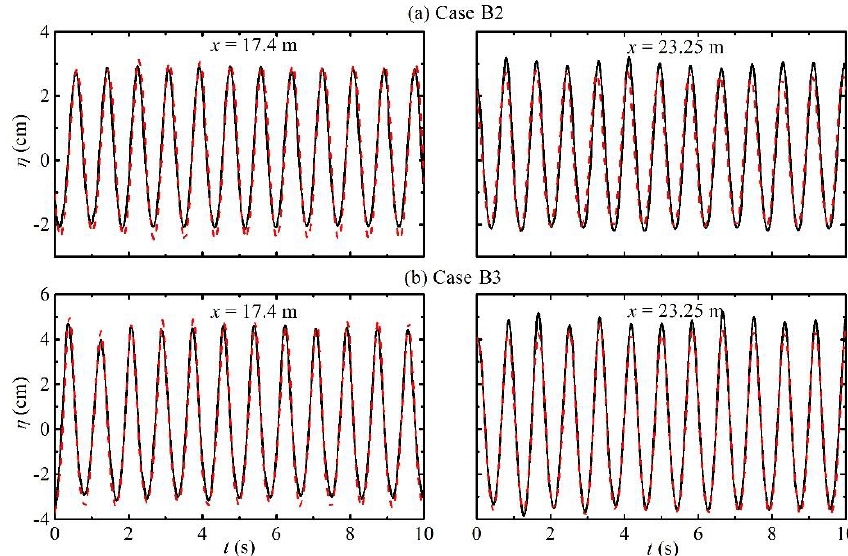
Figure 7. Same as Figure 6 but for the case with f = 1.2 Hz.